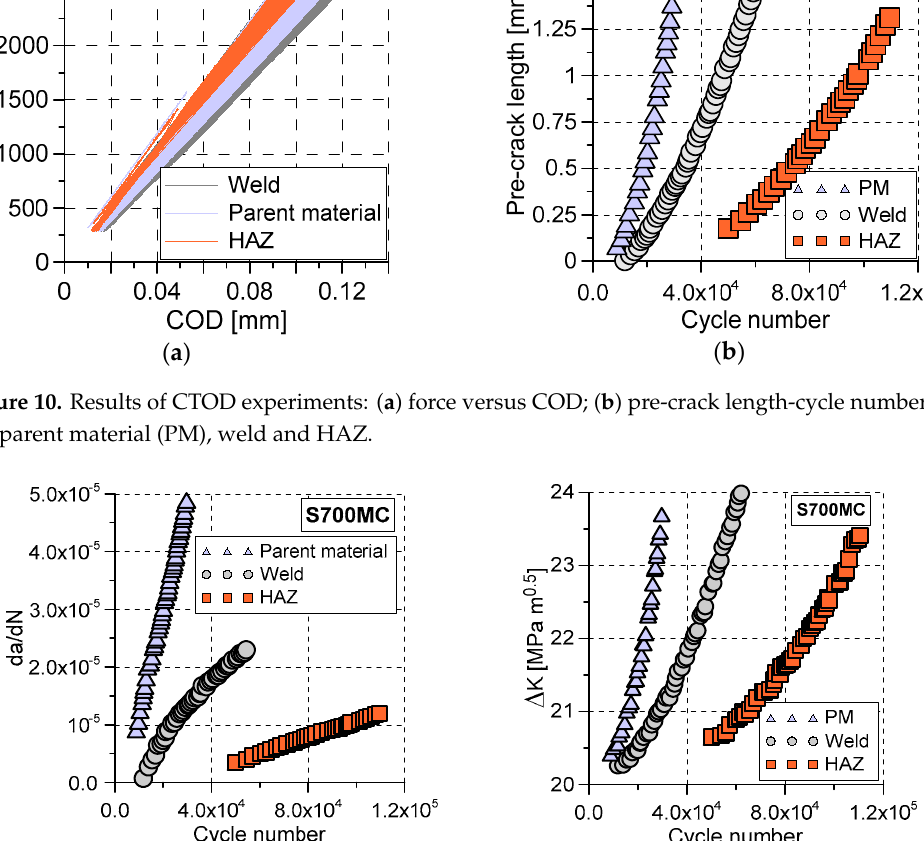
Figure 12. CT mini-specimens before the propagation of the fatigue pre-crack: ( a ) parent material; ( b ) HAZ; ( c ) weld.